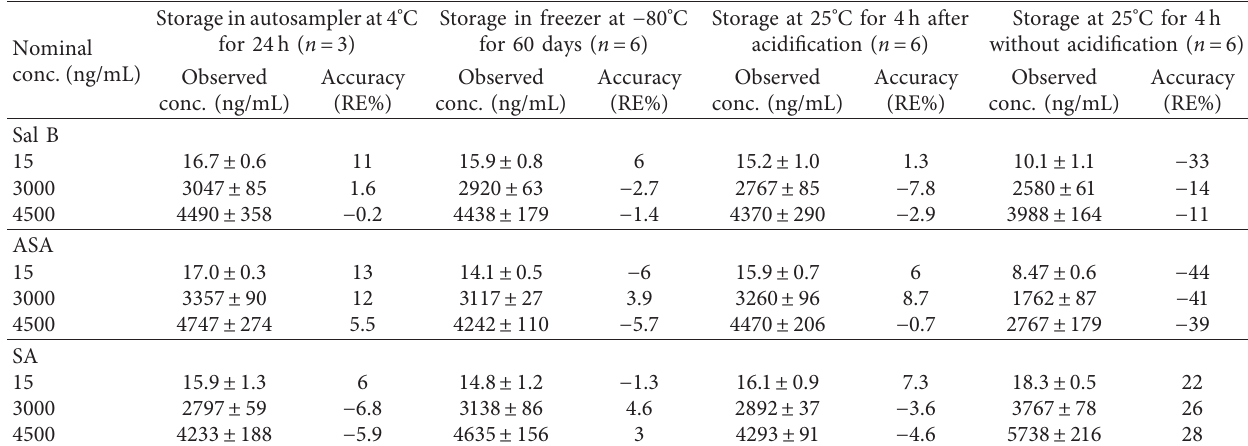
Table 5: Stability of Sal B, ASA, and